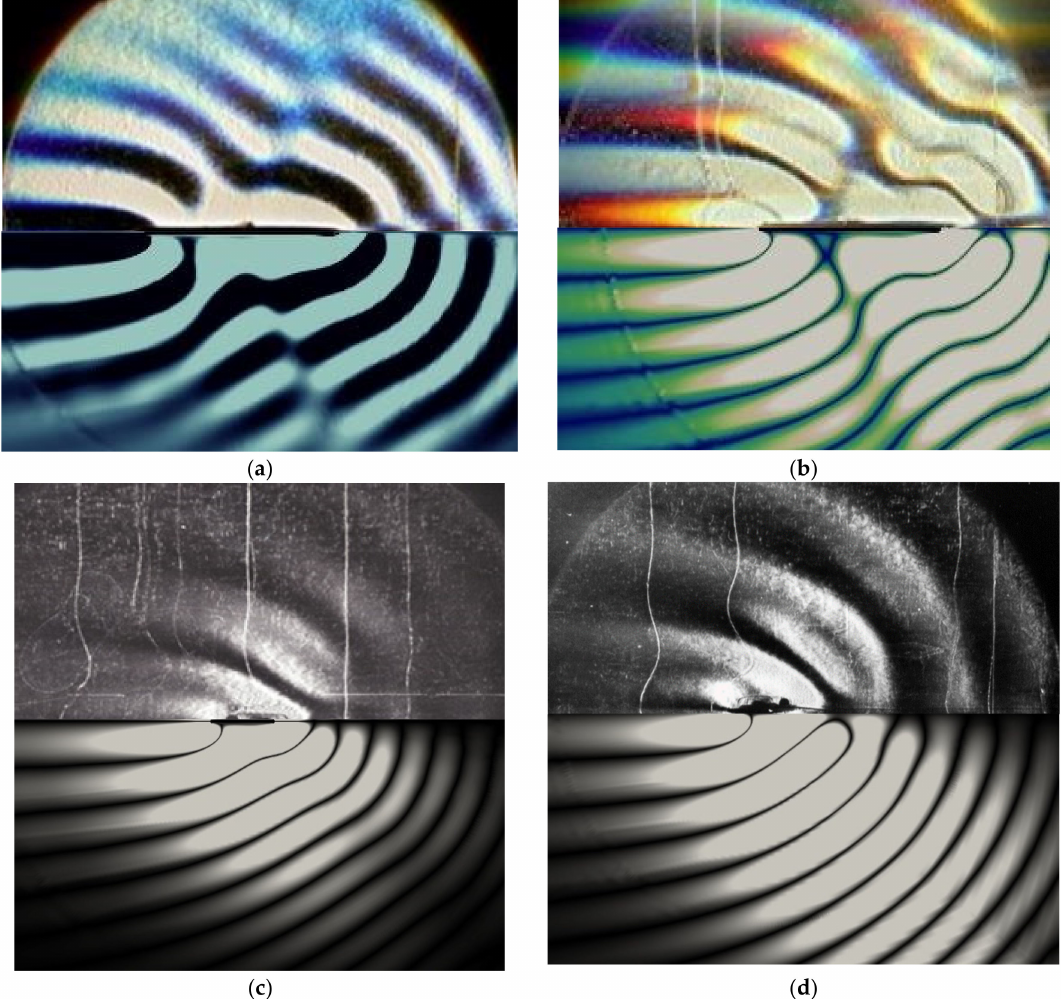
Figure 5. Schlieren (upper part of the images) and calculated (lower one) stratified flow patterns around a moving horizontal plate: ( a , b )— T b = 7.6 s, L = 7.5 cm, U = 0.27, 0.39 cm/s; ( c , d )— T b = 14 s, L = 2.5 cm, U = 0.17, 0.25 cm/s, thin wavy lines in the Schlieren images are density markers which visualize the horizontal velocity component profile in the fields of upstream perturbations and attached internal